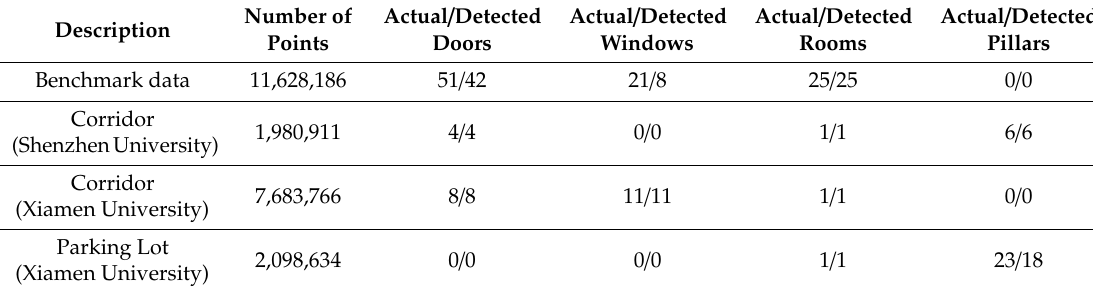
Table 4. Results of basic element extraction.